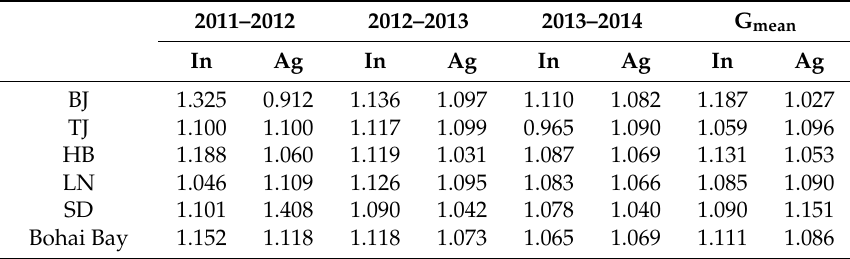
Table 7. TC components of NMWUPI of industry and agriculture,